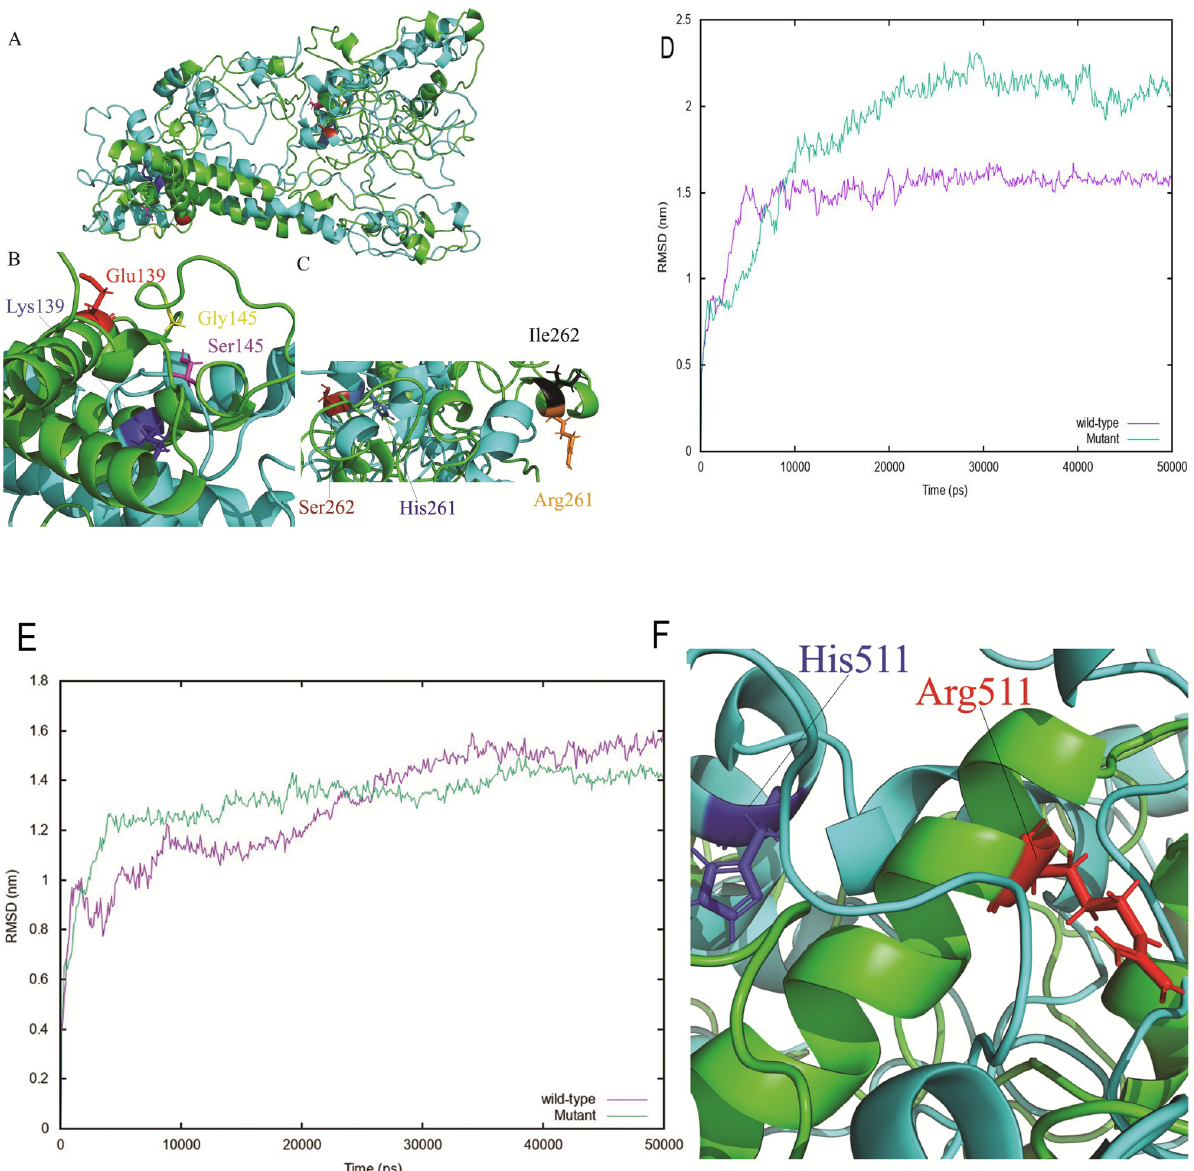
Fig 3. Molecular dynamic simulations for KCNJ12 and CATSPER2 . A: 3D protein structure of mutations in KCNJ12 comparing the wild type (red) and mutant (blue) forms. B: KCNJ12 residue change at Glu139 (red) to Lys139 (blue) and Gly145 (yellow) to Ser145 (pink). C: KNCJ12 residue change at Arg261 (orange) to His261 (skyblue), and Ile261 (black) to Ser262 (firebrick). D: Root mean square displacement of all KCNJ12 atoms in wild type (purple) and mutant form (green). E: Root mean square displacement of all CATSPER2 atoms in wild type (purple) and mutant form (green), and F: CATSPER2 residue change at Arg511 (red) to His511